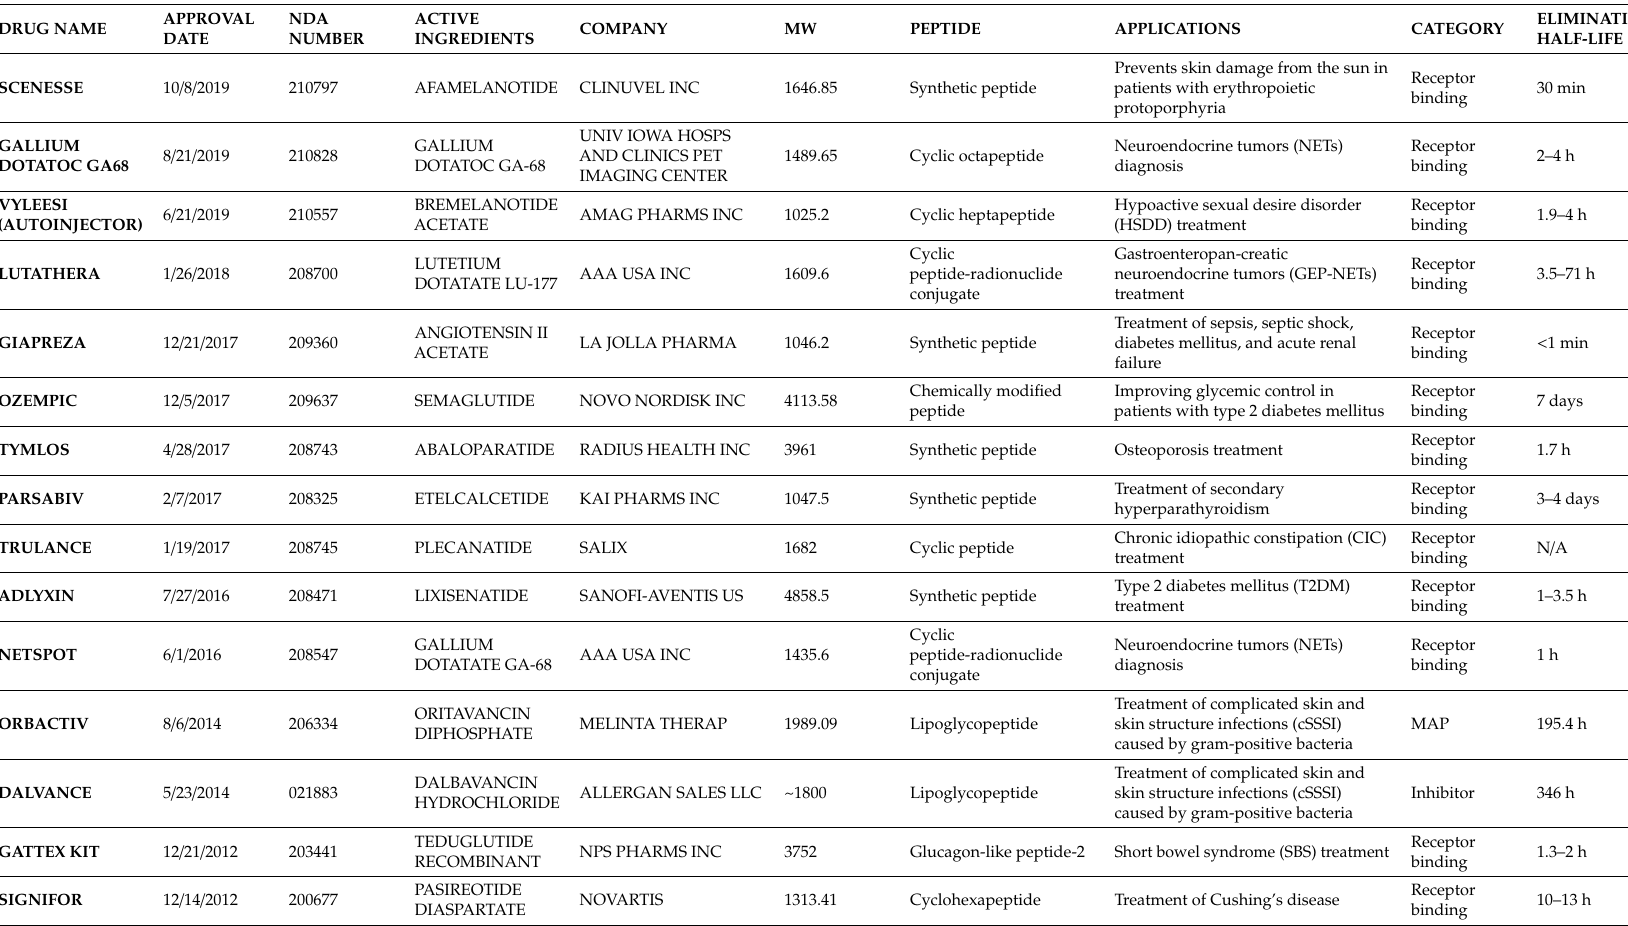
Table 1. Summary of the small peptide (less than 50 amino acids) therapeutics approved by the FDA between January 1999 and December 2019. Raw data (submission classification: Type 1—New Molecular Entity) were collected from Drugs@FDA (http: // www.fda.gov / drugsatfda) and the data were further confirmed by DrugBank [50]. “MAP” is defined as “membrane-active